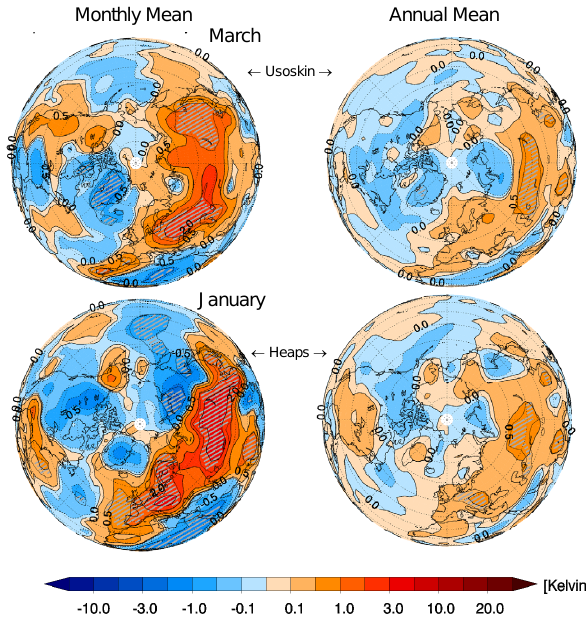
Fig. 9. Effect of GCRs on SAT, [SAT] GCR -[SAT] control , given in Kelvin for monthly means (left) and annual mean (right). Upper panels: using ionization rate modeled by Usoskin et al. (2010). Lower panels: using parameterization by Heaps (1978). Results are averaged from 1978–2002 (after allowing for a 2-year model spin-up). Reddish colors: positive changes. Bluish colors: negative changes. Hatched areas (enclosed by thick solid contours) indicate changes with at least 95% statistical